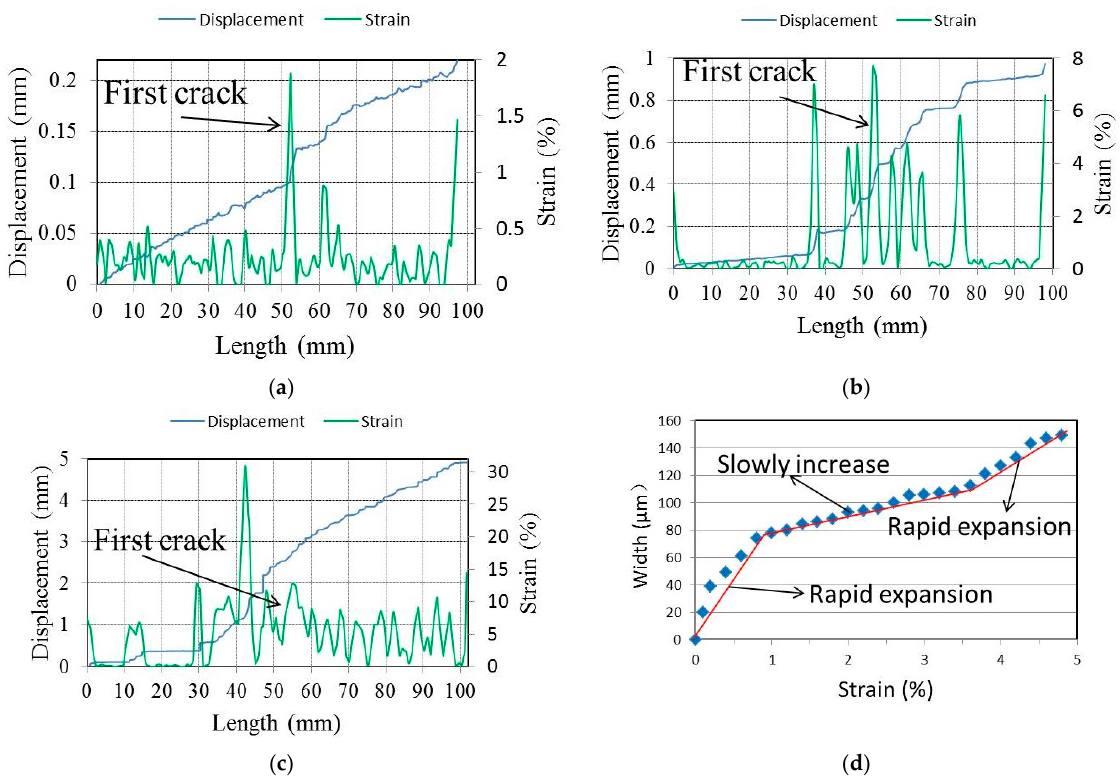
Figure 10. The strain and displacement distribution diagrams of the tensile specimen. ( a ) The initial crack state; ( b ) the multiple crack state; ( c ) the ultimate crack state; ( d ) the variation in the first crack’s width.